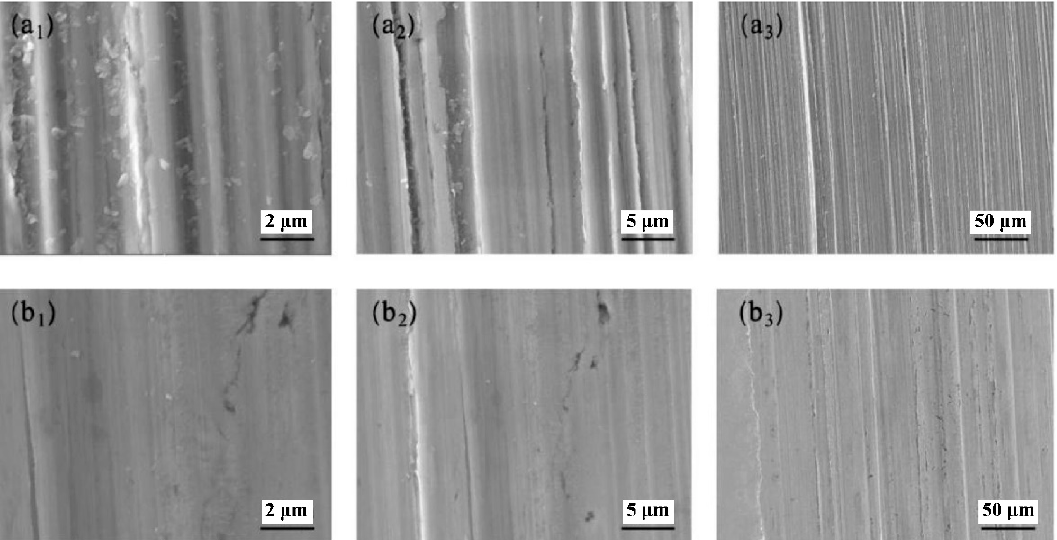
Figure 13. SEM images of the wear scar on the steel surface with: ( a 1 – a 3 ) the distilled water; and ( b 1 – b 3 ) the 2 wt.% JD2000 aqueous solution.